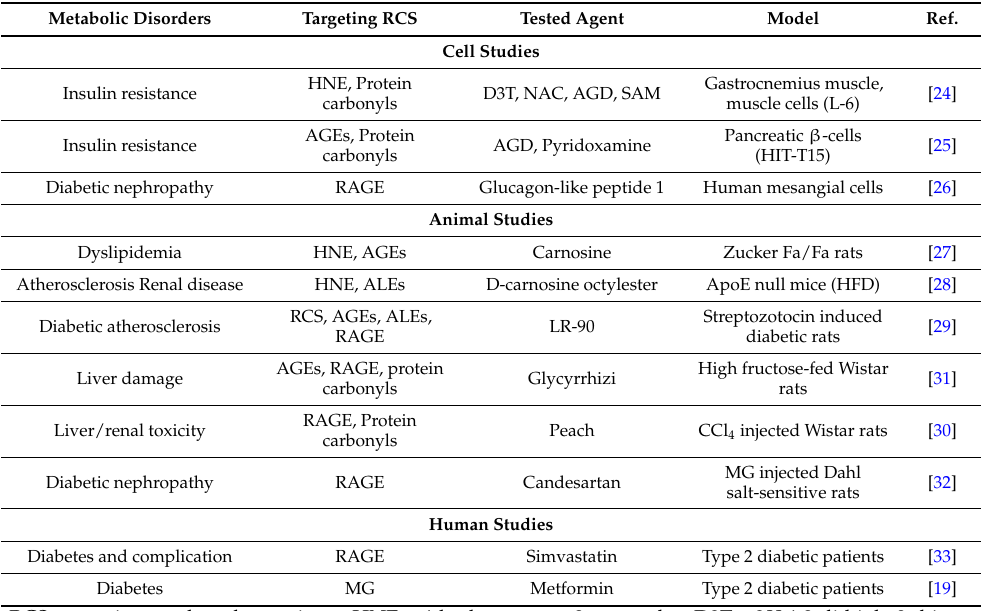
Table 1. Studies targeting reactive carbonyl species to prevent metabolic